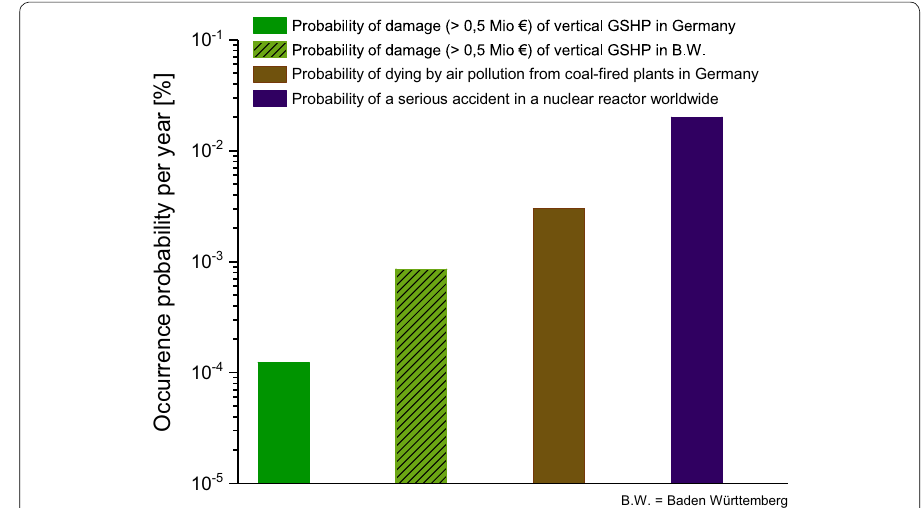
Fig. 6 Probability of occurrence per year of damage events in the amount of more than 500,000 Euros in Germany in comparison with two other non-geothermal probabilities, such as dying by air pollution and seri- ous accident at a nuclear reactor